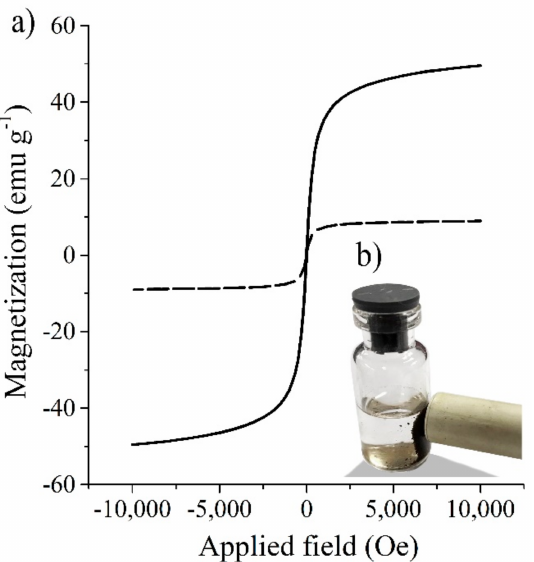
Figure 8. The ( a ) magnetization curve of MAG (solid) and MAG–CLI (dash), and ( b ) magnetic separation of the spent MAG-CLI from suspension.